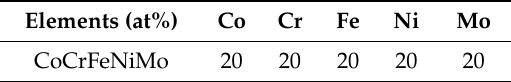
Table 1. Nominal composition for CoCrFeNiMo.